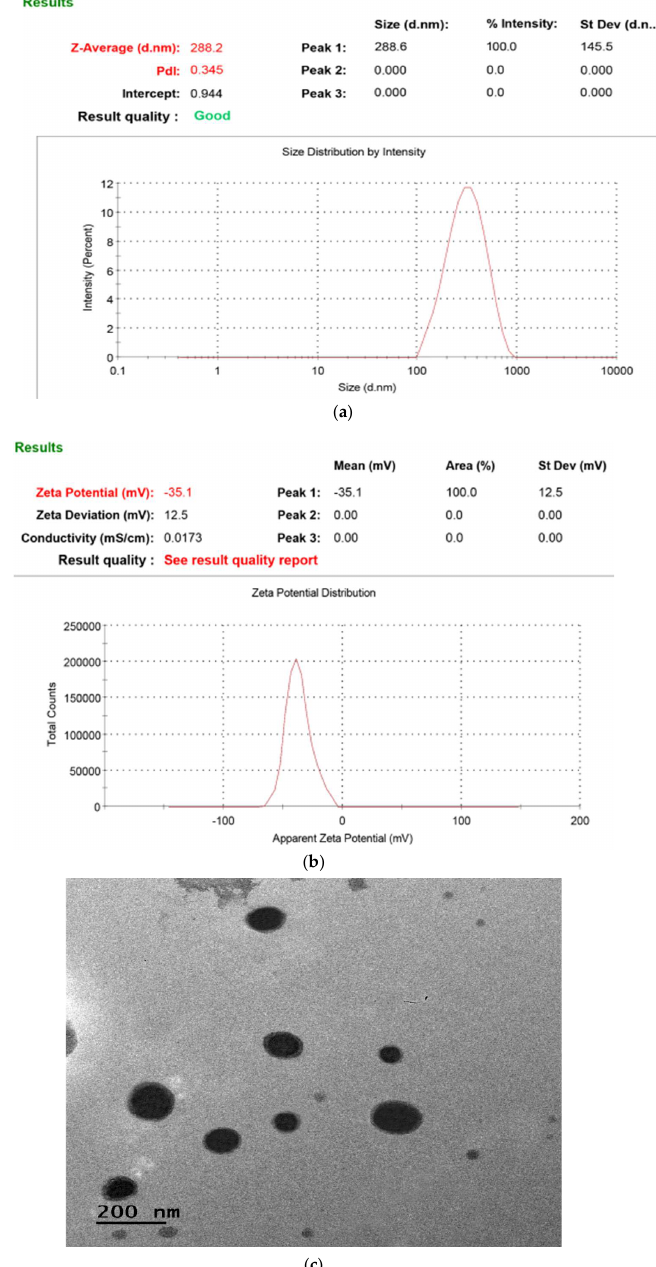
Figure 3. Particle characterization: ( a ) particle size and PDI analysis; ( b ) zeta potential analysis; ( c ) TEM analysis .